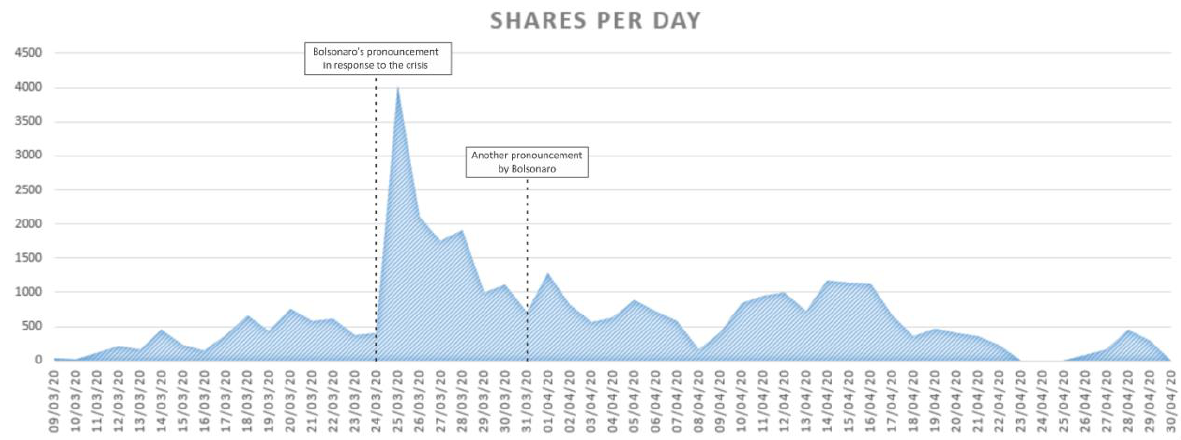
Figure 2. Number of shares per